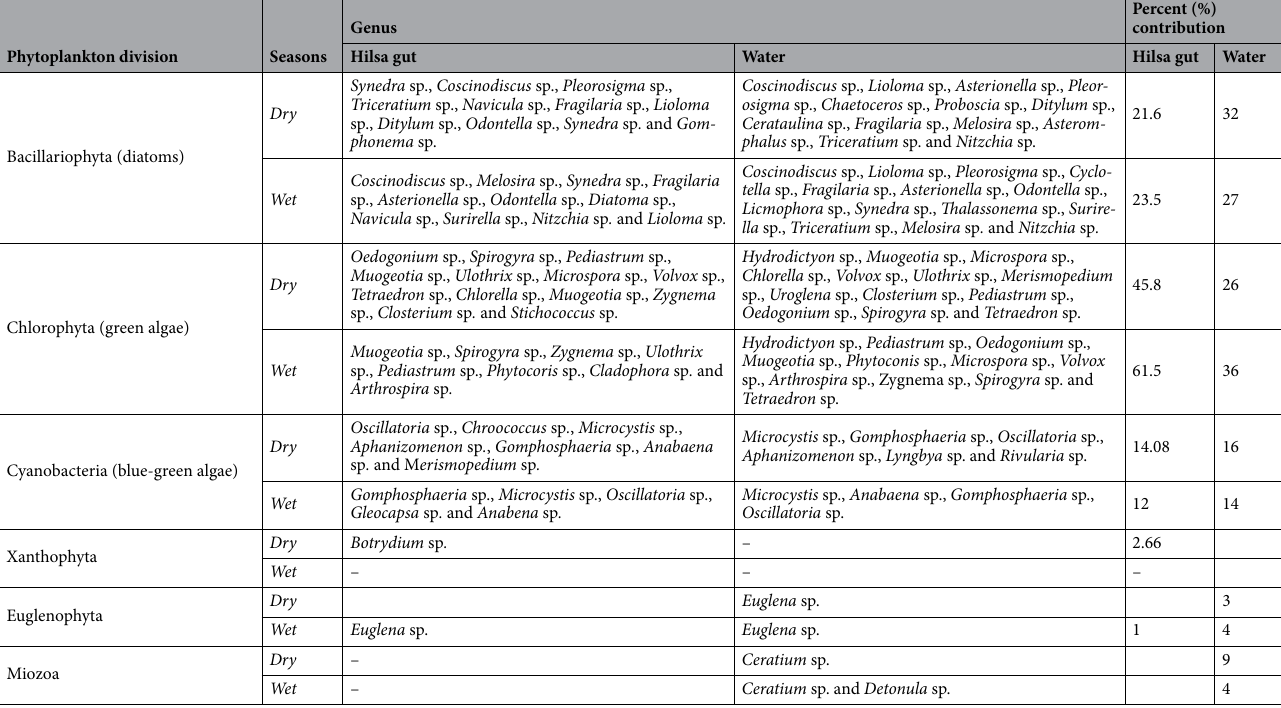
Table 3. Phytoplankton genera observed in the hilsa gut and water.